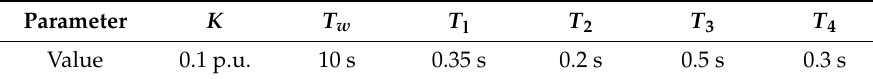
Figure 5. The schematic diagram of the PODC. Table 3. The data of the PODC.